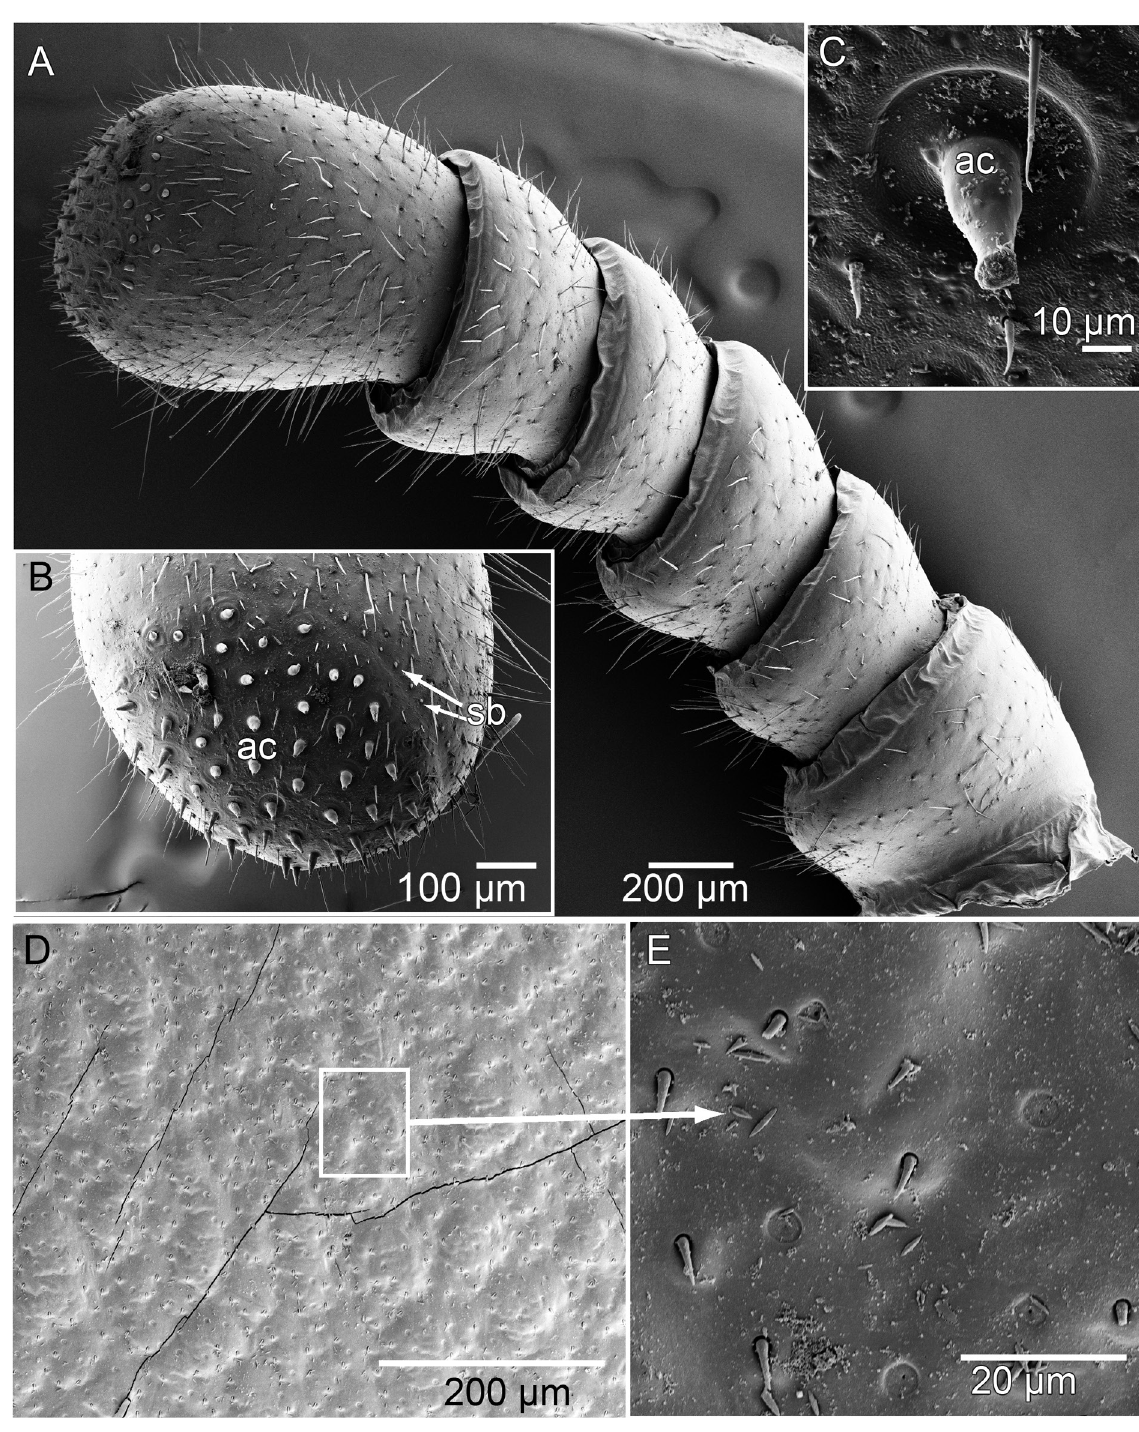
Fig. 3. Sphaerobelum aesculus Rosenmejer & Wesener sp. nov., holotype, ♂ (NHMD 621693), scanning electron micrographs. A . Right antenna, lateral view. B . Right antenna, disc. C . Detail of apical cone. D . Tergite surface of midbody ring. E . Tergite surface at very high magnification. Abbreviations: ac = apical cone; sb = sensilla